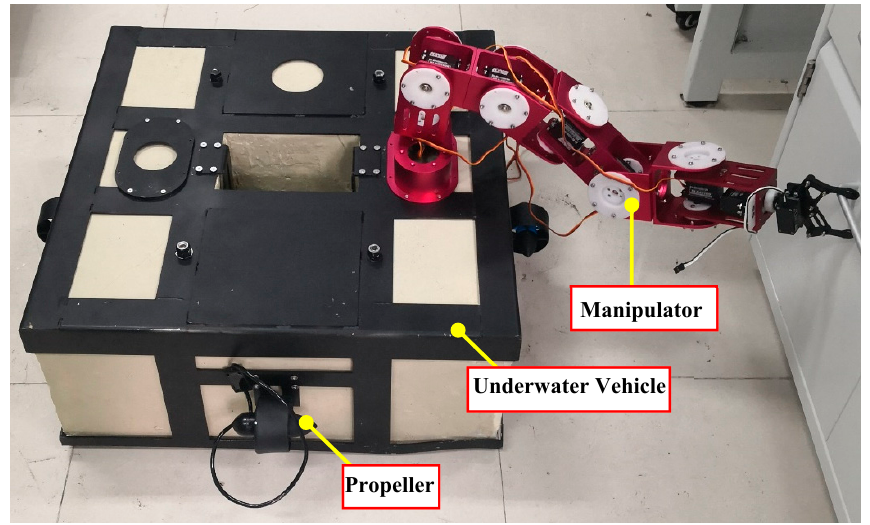
Figure 16. UVMS Physical Prototype.